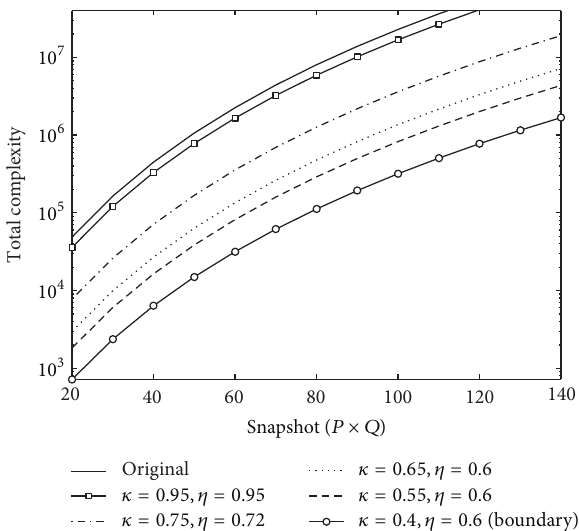
Figure 5: Comparison of hardware complexity under different spatial compression ratio ( 𝜅 ) and temporal compression ratio ( 𝜂